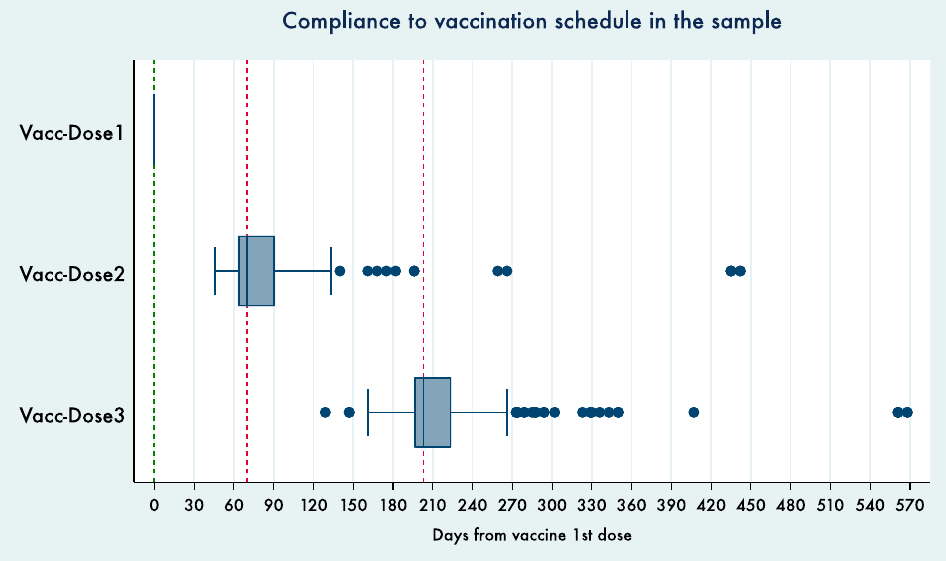
Figure 1. Box plot showing timings of second and third dose